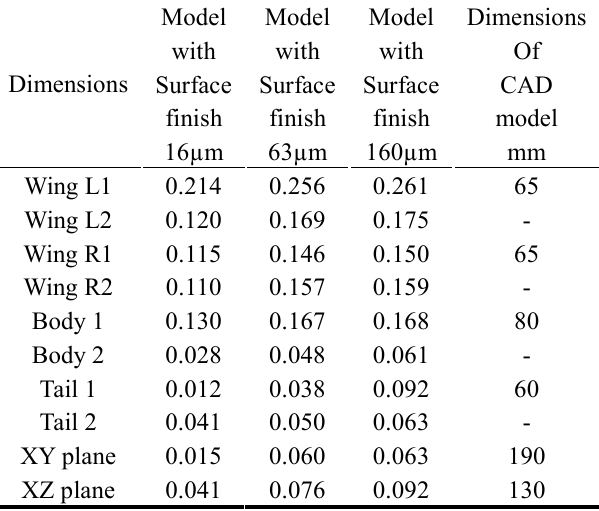
Table 5. Model dimensions compared